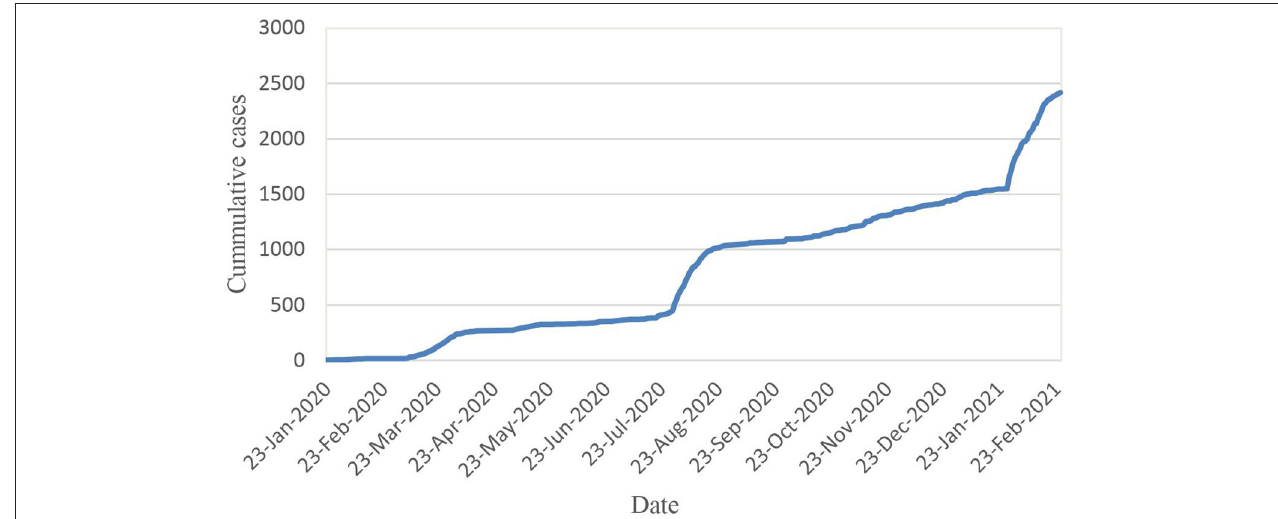
FIGURE 1 | Cumulative COVID-19 cases recorded in Vietnam from 23 Jan 2020 to 23 Feb